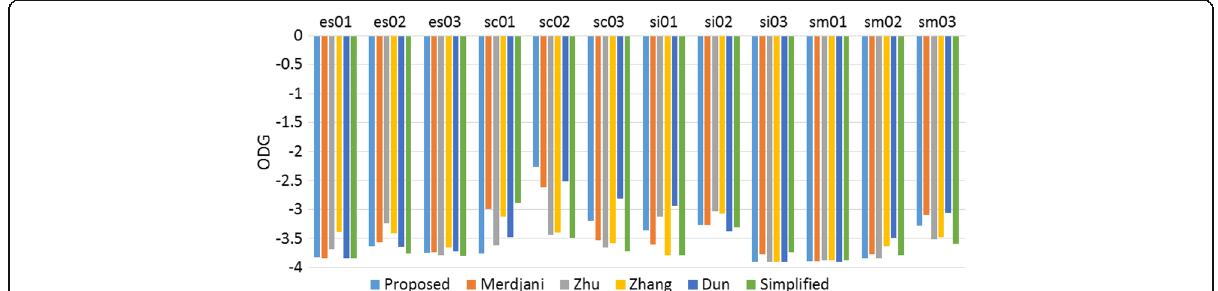
Fig. 6 Audio quality comparison by ODG. Using the original audio signals as references, ODG of each reconstructed audio is evaluated by software